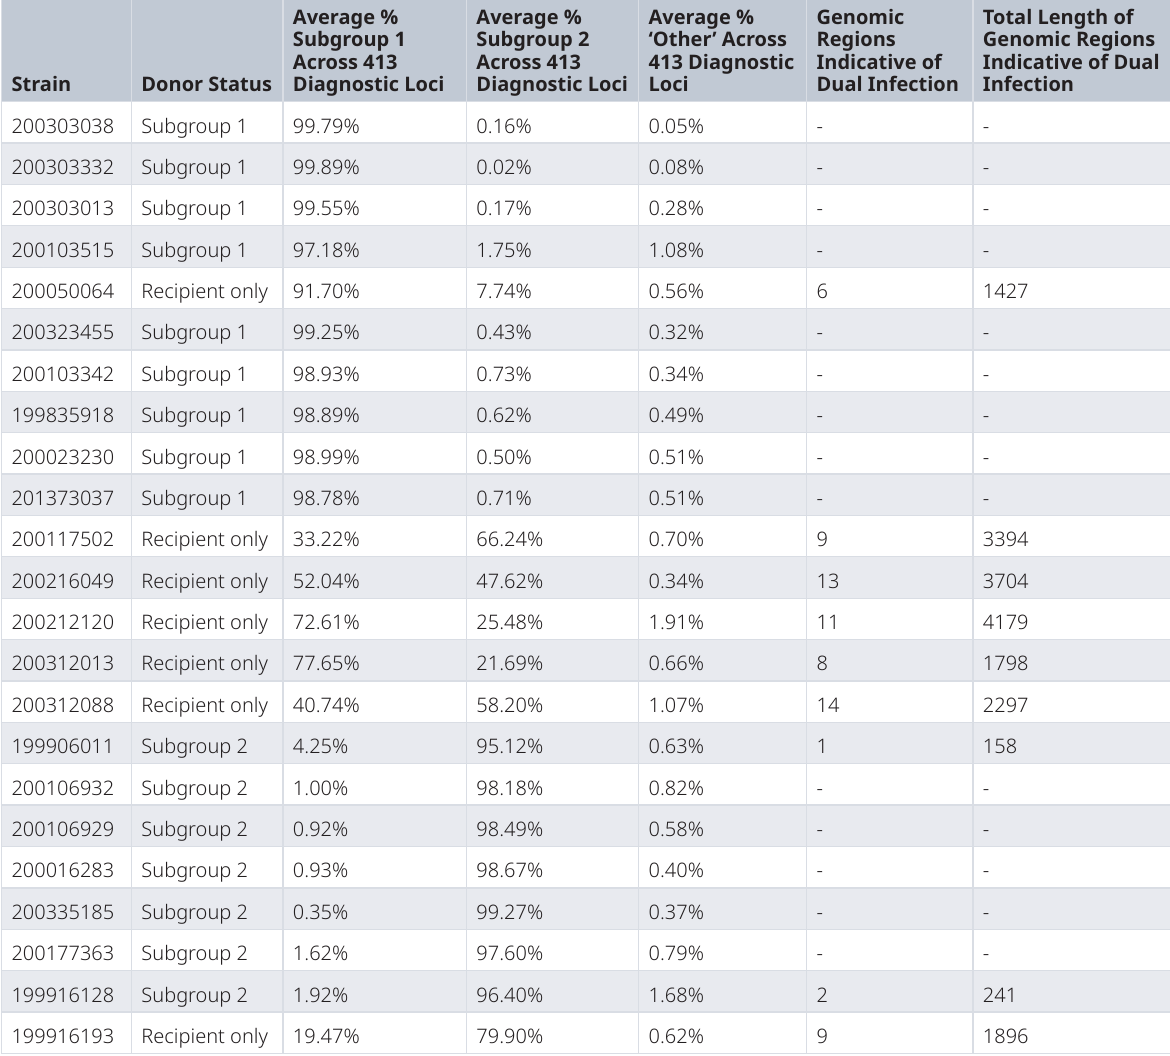
Table 4. Subgroup specific intra-host genetic variation (quasispecies) for 23 SRLV A2 consensus genomes. Donor status is the population of donor genomes to which a consensus genome was assigned in the final subgroup 1 vs subgroup 2 recombination model (Figure